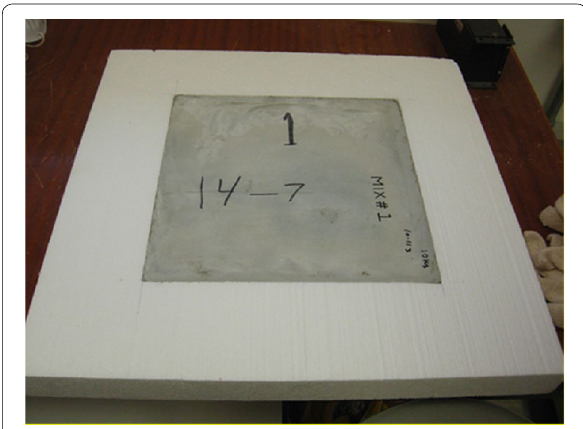
Fig. 3 Test specimens for evaluation of the thermal conductivity of concrete.